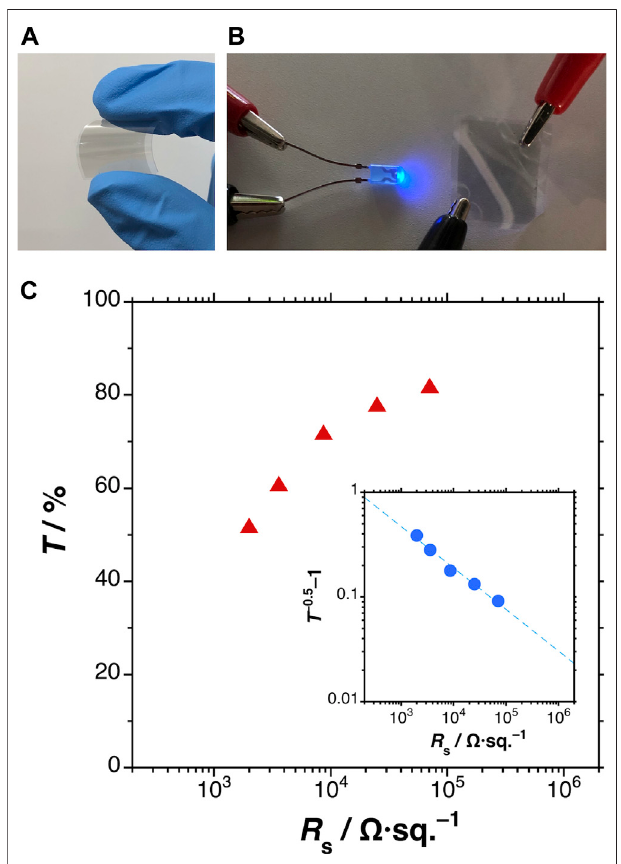
FIGURE 6 | (A , B) Typical photographs of the fabricated MXene transparent conductive fi lms; (C) plots of transmittance at 600 nm (main) and T − 0.5 – 1 (inset) versus average sheet resistance of the MXene fi